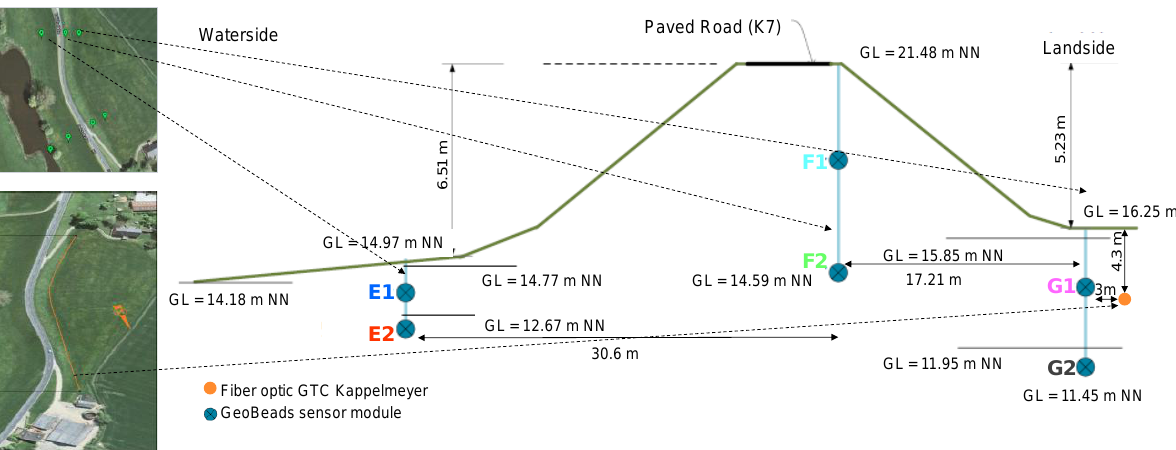
Figure 12. Alert Solutions sensors (marked with green balloons—left part of the picture, marked with blue circles—right part of the picture) and GTC Kappelmeyer fibre optic cable (marked with orange line) installed into the Rhine levee—second cross-section, left slope—waterside slope of the levee, right—landside slope.